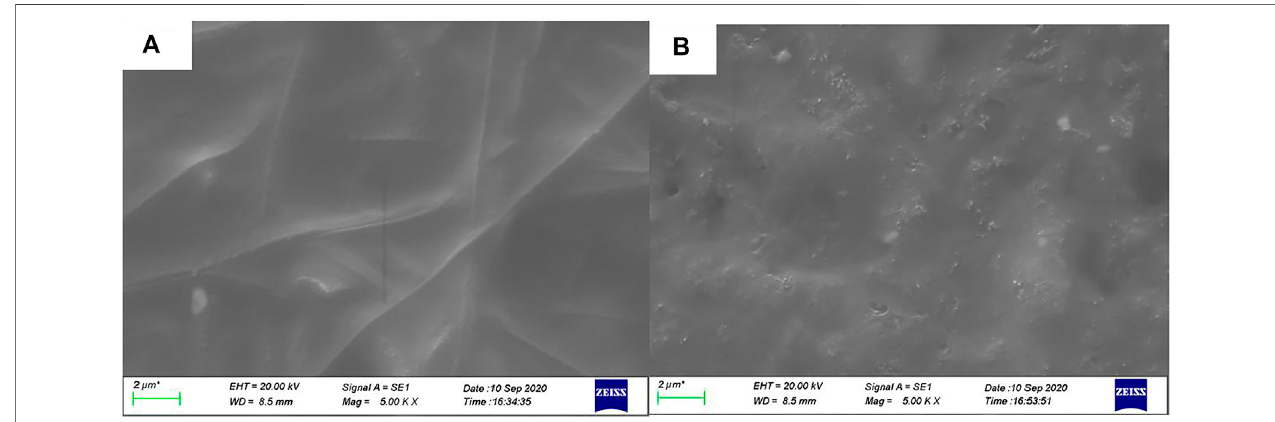
Frontiers in Chemistry |